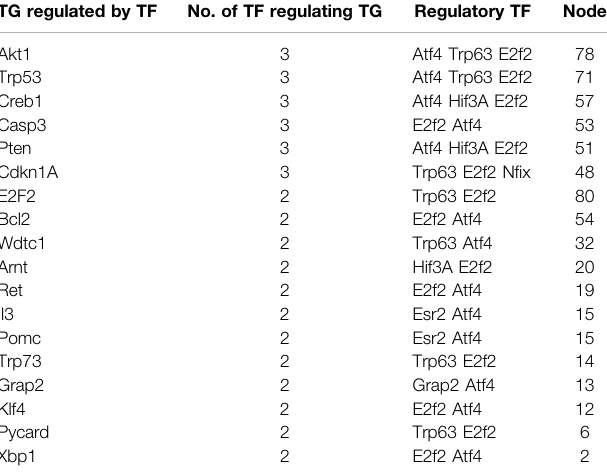
TABLE 2 | Statistics of genes regulated by transcription factors. TG regulated by TF No. of TF regulating TG